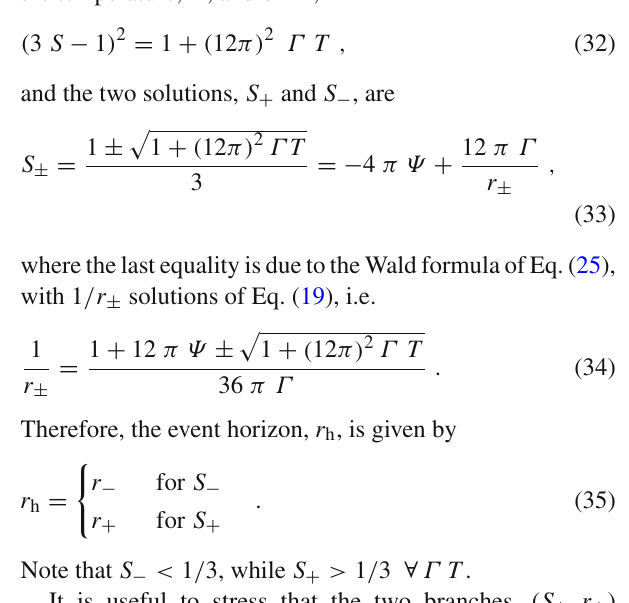
Fig. 1 S as a function of Γ T from Eq. (32): if the entropy is greater than 1 / 3 the solution is given by S + and r + , otherwise by S − and r − . In bold we indicate the only physically acceptable values with Γ T > 0